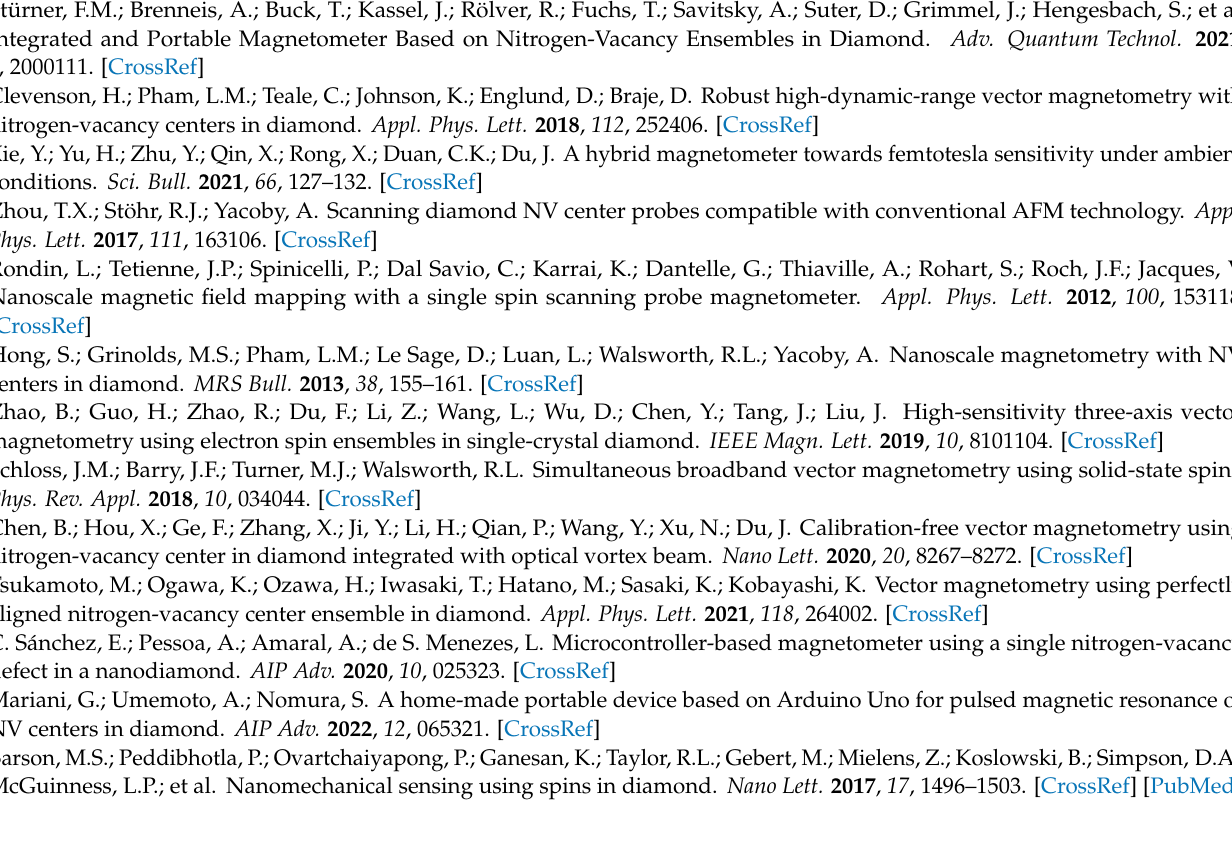
where ∆ f i = f i , + − f i , − , i ∈ { 1, 2, 3, 4 } is the frequency difference in the Zeeman splitting for the m S = ± 1 spin states for all four NV orientations and γ = 28 MHz/mT is the gyromagnetic ratio. Equation (A3) is based on the geometric properties of the NV axes in the diamond lattice. It follows from rearranging the expressions for the axial magnetic = (cid:126) B · (cid:126) NV = ∆ f ( 2 γ ) with the normalized vector field for all 4 NV orientations B i i / i , (cid:107) representation of the four NV axes given by the Miller indices of the crystal lattice that √ √ describe the possible orientations [33] (cid:126) NV 1 = ( − 1, − 1, − 1 ) / 3, (cid:126) NV 2 = ( − 1, 1, 1 ) /